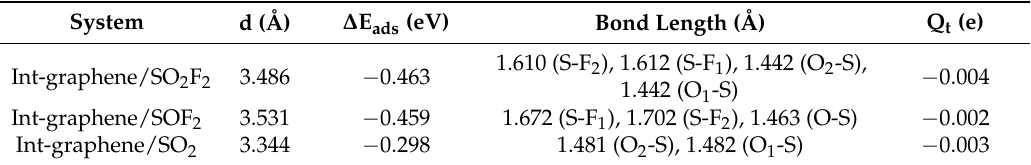
Table 2. Doping formation energy of an Ag-doped graphene surface.